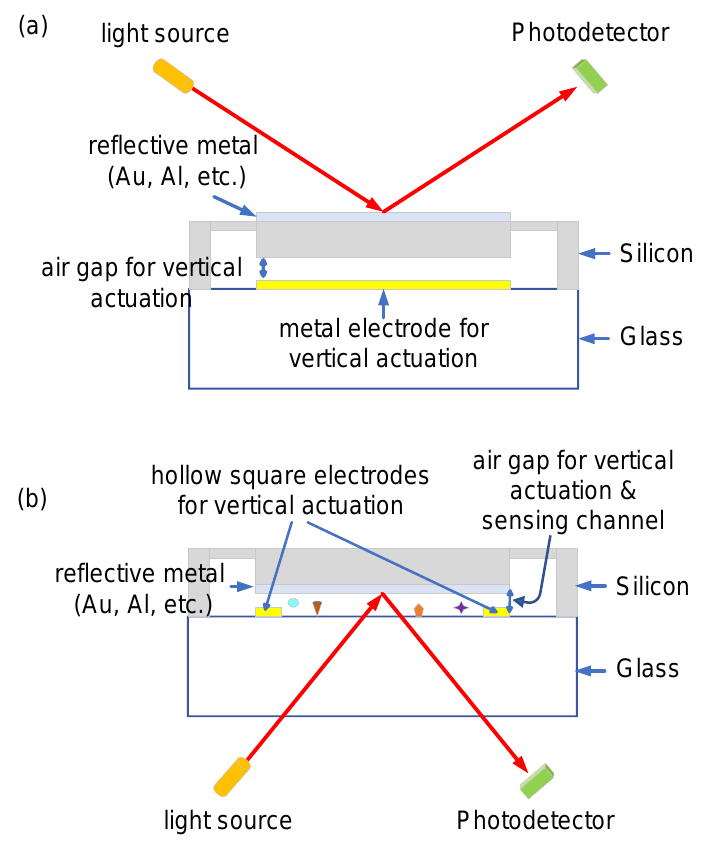
Figure 1. Optical MEMS device structure. ( a ) general structure and ( b ) structure with hollow square metal electrode for Otto configuration.